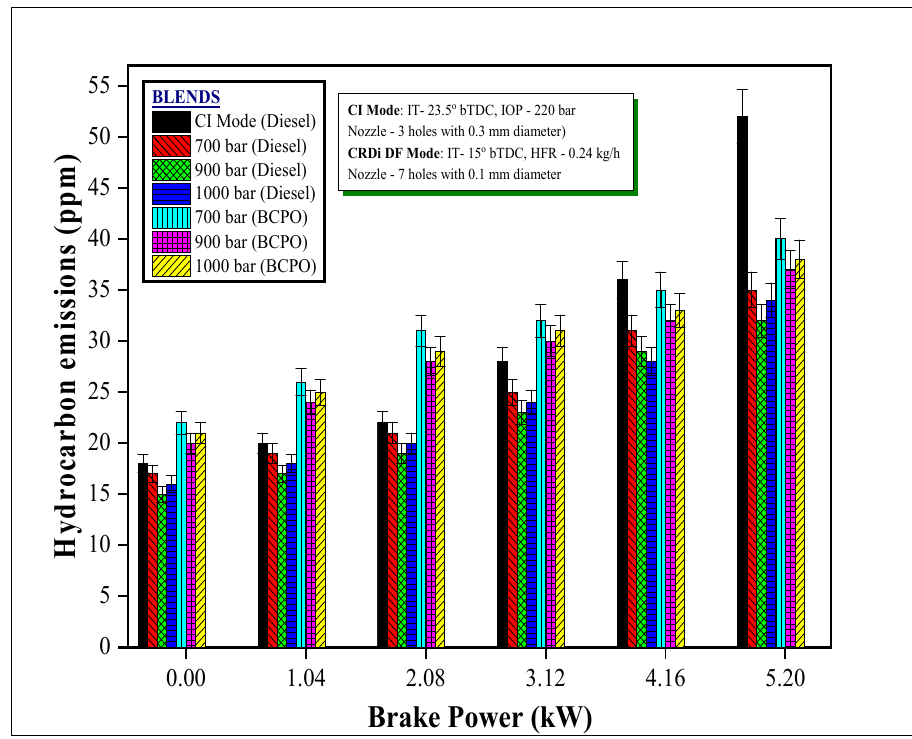
Figure 10. IP and BP influence on CRDi engine HC emissions.